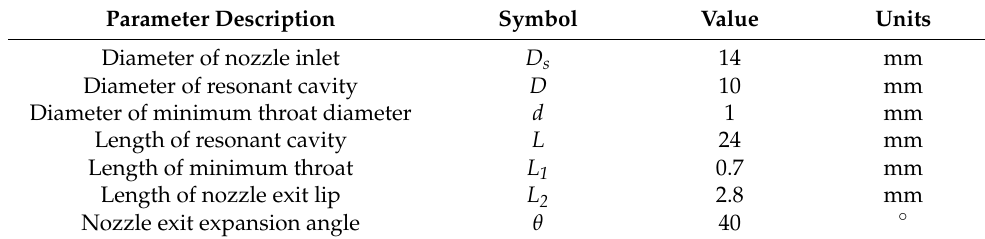
Figure 2. Schematic diagram of the experimental nozzle. Table 1. The dimensions of the experimental nozzle.